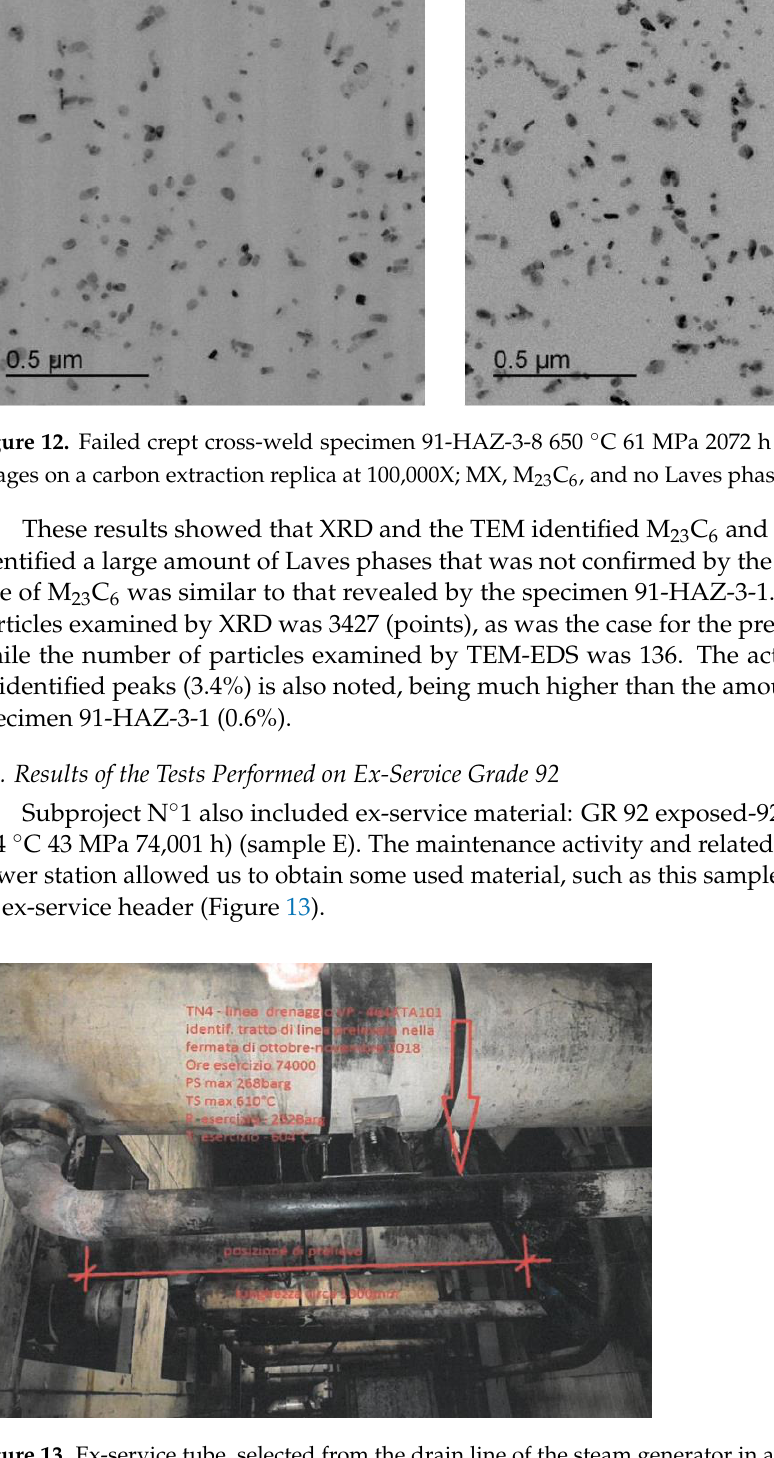
Figure 13. Ex-service tube, selected from the drain line of the steam generator in a coal power plant. In the following tables (Tables 9 and 10), its chemical analysis and mechanical properties are reported. Table 9. Ex-service tube's chemical analysis (extracted from the original certificate).